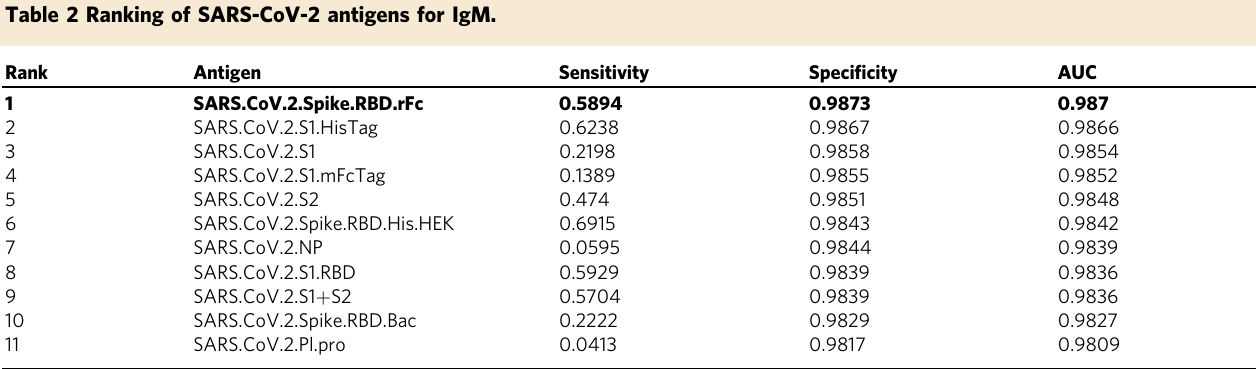
Table 2 Ranking of SARS-CoV-2 antigens for IgM.